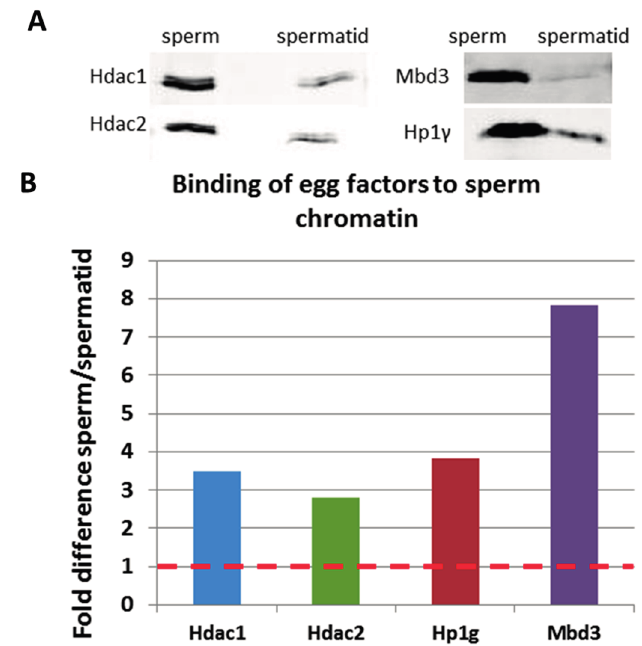
Figure 7. Validation of mass spectrometry results by immunoblotting. ( A ) Immunoblotting results on proteins isolated from sperm and spermatids after extract treatment. “sperm”—proteins